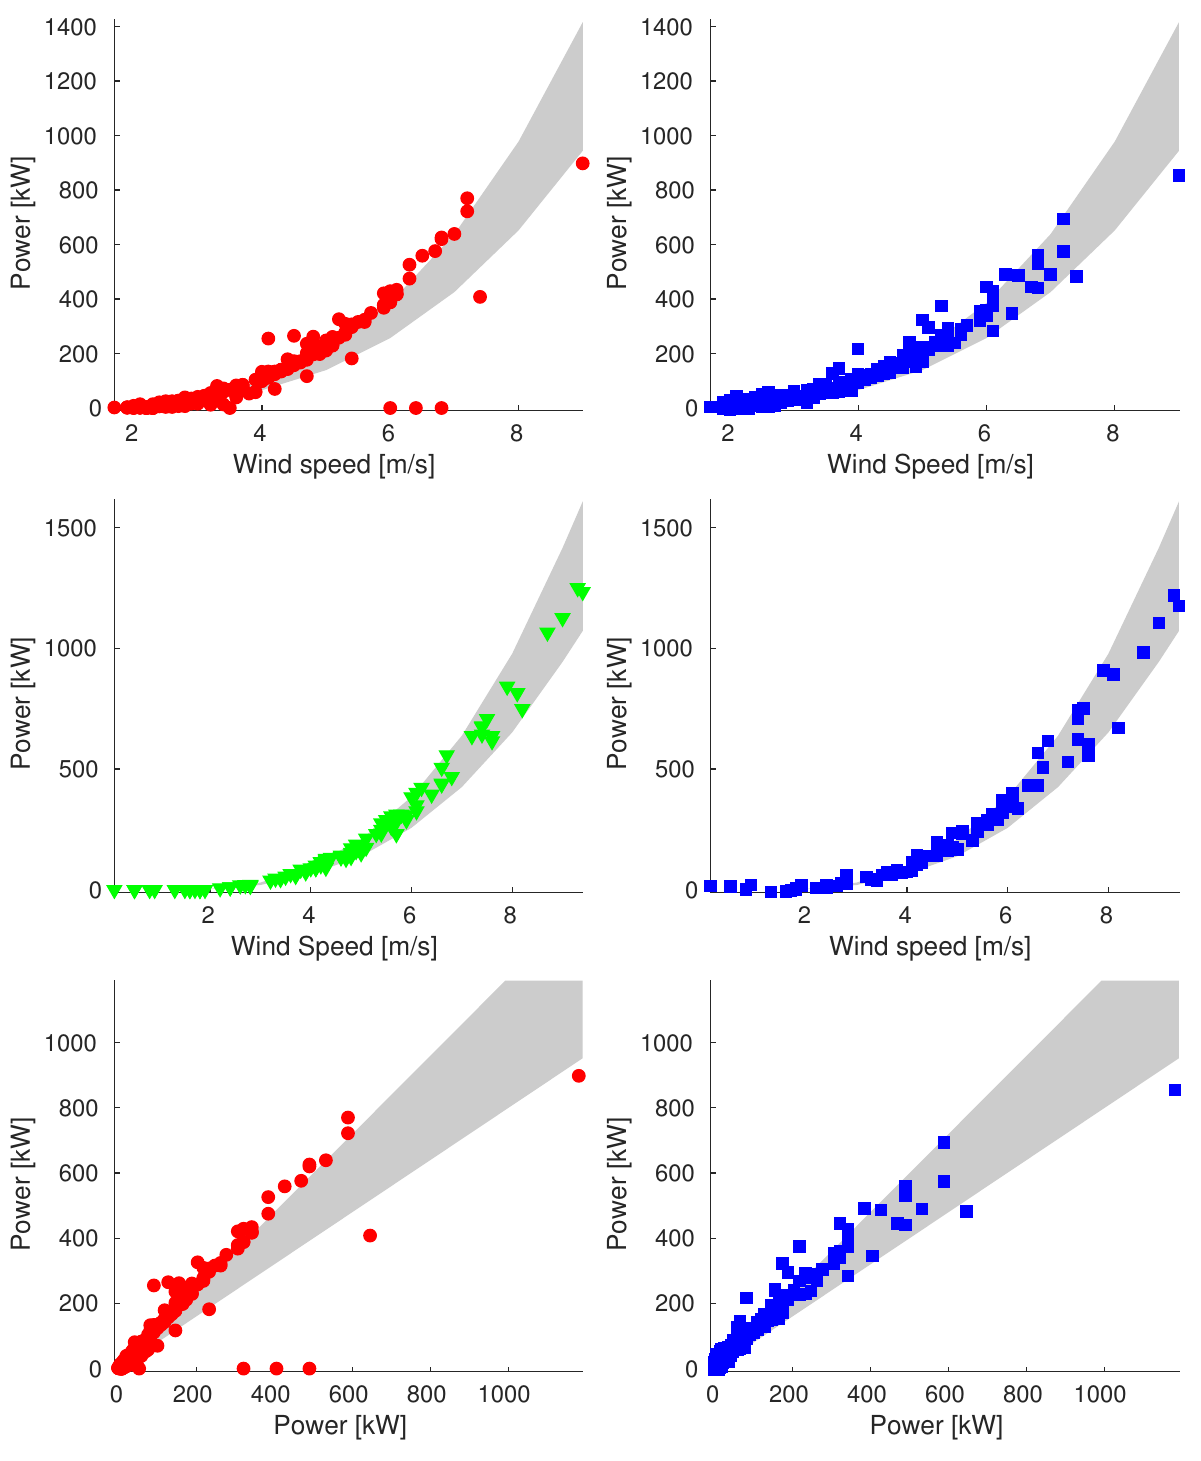
Figure 4. Plot of reconstructions for data points of 26 February ( Sample_75 ). We compare original data (on the left ) and reconstructed values (on the right ). We show plots of power vs. wind speed of rejected and validation data ( up and middle , respectively) and plot of power vs. ideal power of rejected data ( bottom